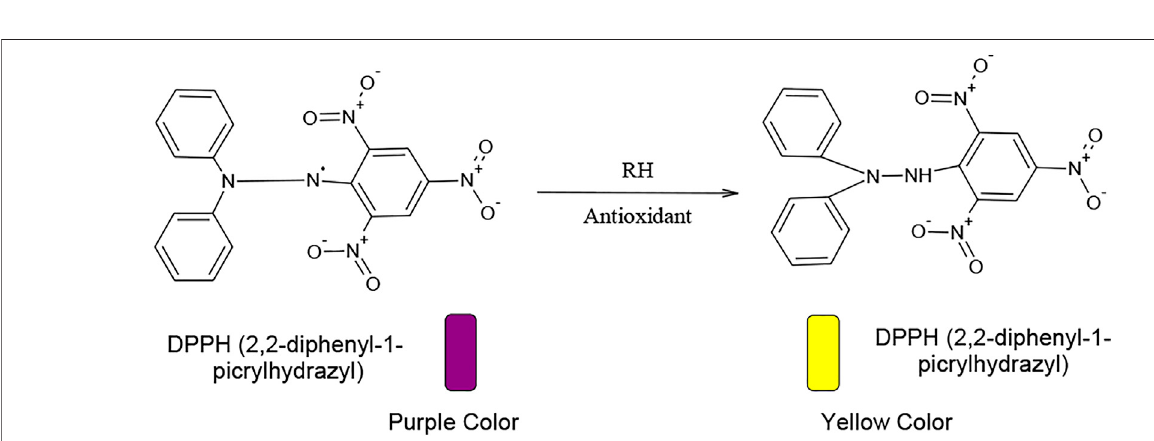
FIGURE 3 | Mechanism of